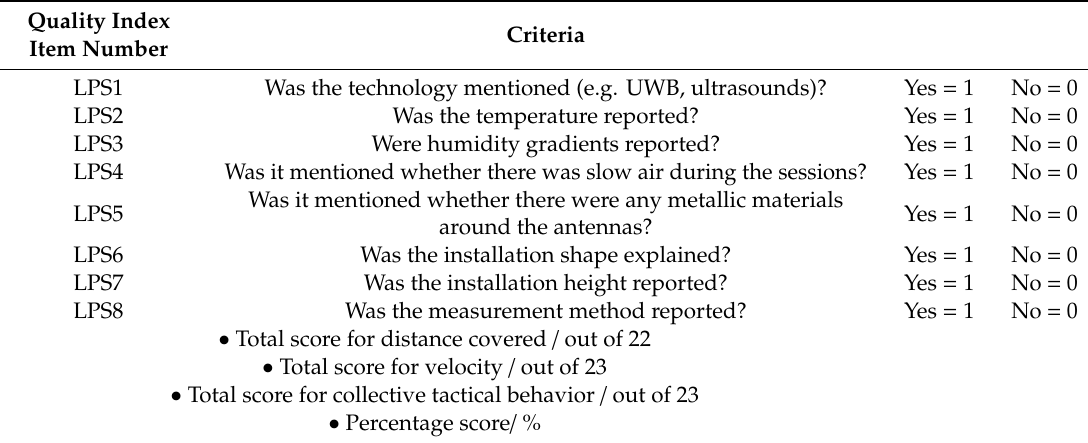
Table 3. Check sheet for assessing external workload or collective variables using LPS in sports. Quality Index